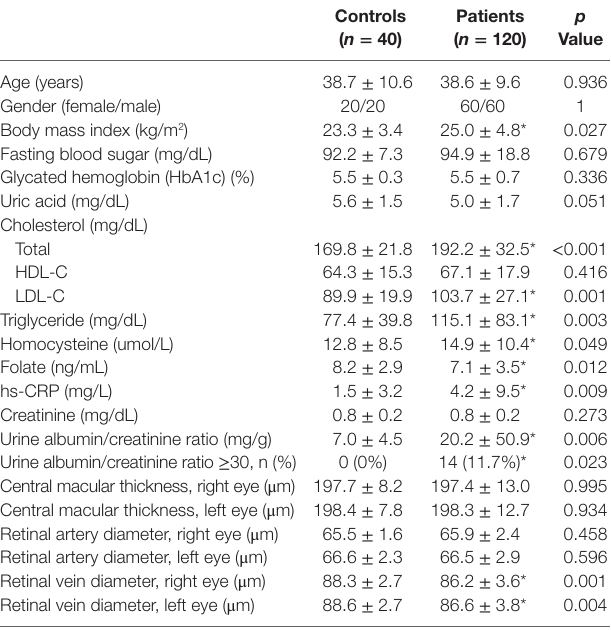
TaBle 3 | Correlation analysis of the effects of candidate risk factors on microangiopathy in patients with epilepsy and controls.